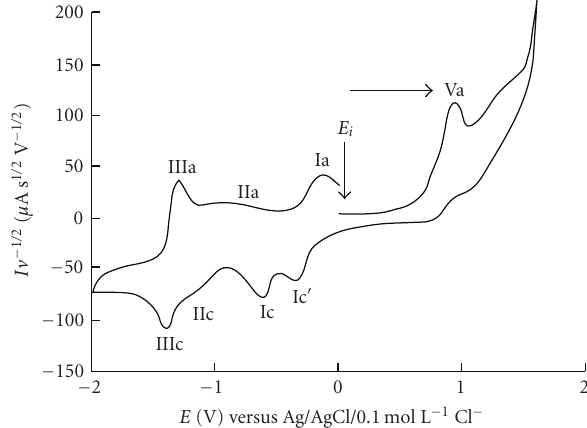
Figure 4: Cyclic voltammogram of isolapachol, DMF + 0.1 molL − 1 TBAP, GCE versus Ag/AgCl/0.1 molL − 1 NaCl, c = 2 mmolL − 1 . Initial potential = 0 V, v = 0 : 100 Vs − 1 . Positive Scan